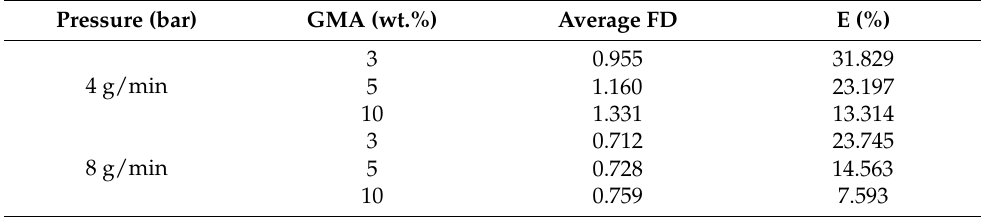
Table A5. Effect of variation in scCO 2 flow on recycled PE-g-GMA results. Extruder temperature: